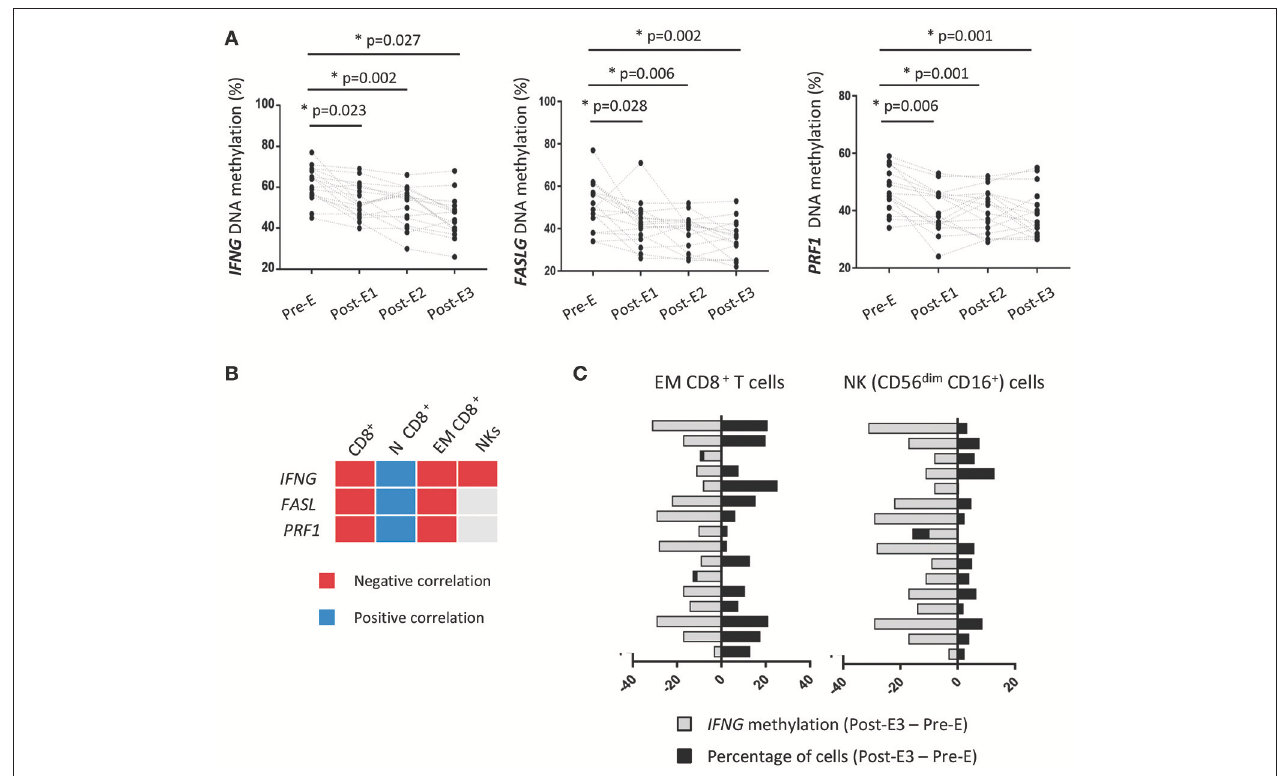
FIGURE 6 | DNA methylation of immune genes in HT patients during the first year post-transplant from the prospective study. (A) The DNA methylation levels of IFNG , FASLG , and PRF 1 genes were quantified by pyrosequencing in PBMCs isolated from HT patients ( n = 16) under early EVL treatment and follow-up at different times during the first year; before EVL initiation (Pre-E), and 1, 3, and 9 months after EVL conversion (Pre-E1, Pre-E2, Post-E3). Each circle represents one HT patient and differences between Pre-E and each time after EVL conversion (Post-E1, Post-E2, and Post-E3) were analyzed by the Wilcoxon test. * p < 0.05. (B) Correlation between the DNA methylation level of each gene and the percentage of CD8 + T cell subsets and NK cells at all assayed times during the first year post-transplant. Negative and positive Pearson correlation coefficients indicate that demethylation of the gene is significantly associated with a higher or lower percentage of the cell subset, respectively. N, naive; EM, effector memory. (C) Association between the loss of IFNG DNA methylation and the increase in the percentage of EM CD8 + T and NK cells for each patient during the first year post-transplant (Post-E3–Pre-E